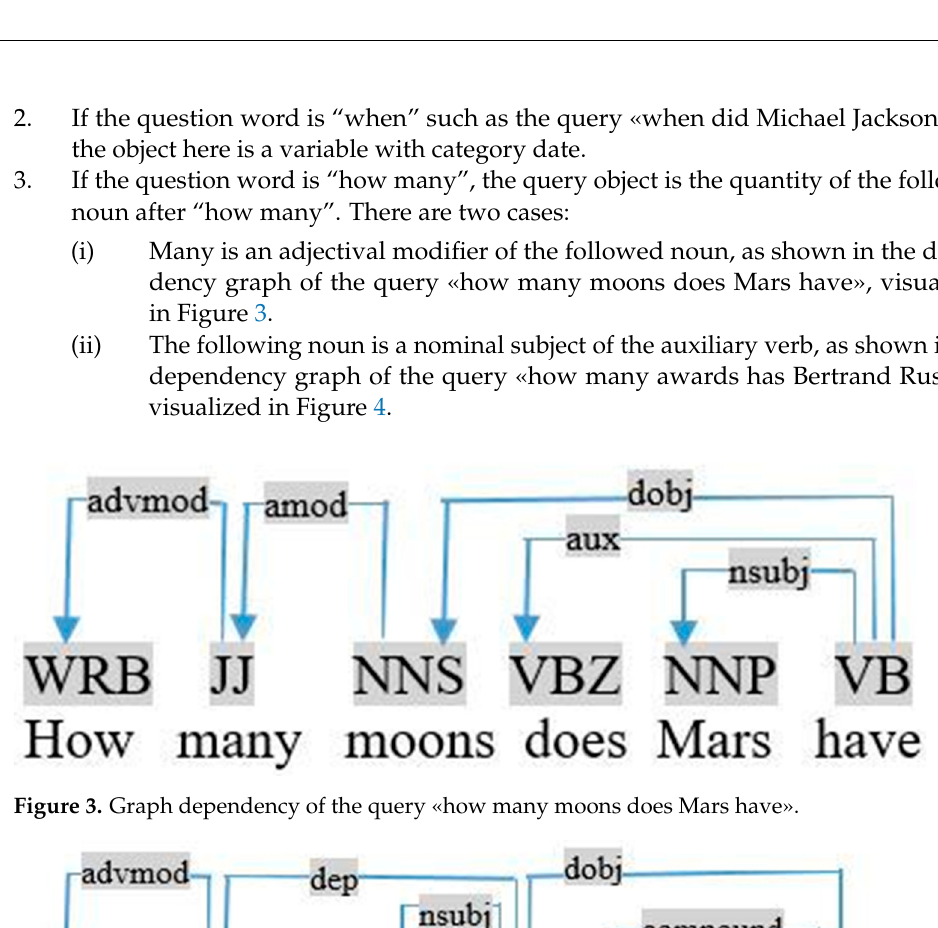
Figure 3. Graph dependency of the query «how many moons does Mars have».